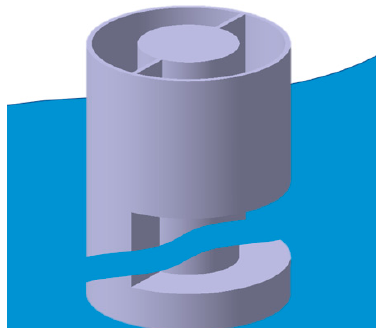
Figure 1. Concept of the dual-cylindrical oscillating water column (OWC) wave energy converter.